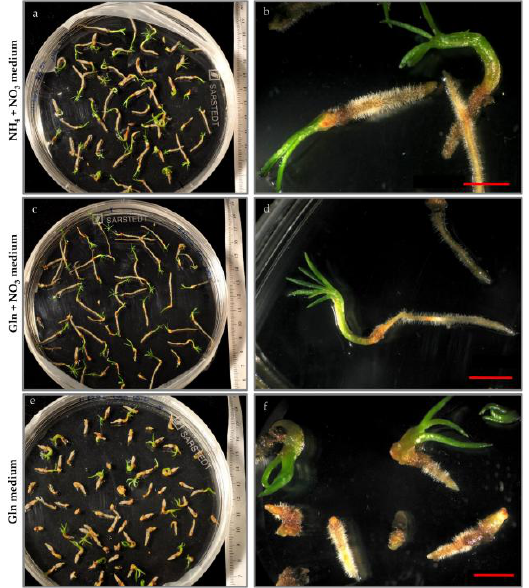
Figure 5. Germination of mature somatic embryos after four weeks on germination medium. Mature embryos were generated on ( a , b ) NH 4 + NO 3 medium; ( c , d ) Gln + NO 3 medium; ( e , f ) Gln medium. Upper bars = 2 mm; middle and lower bars = 5 mm.